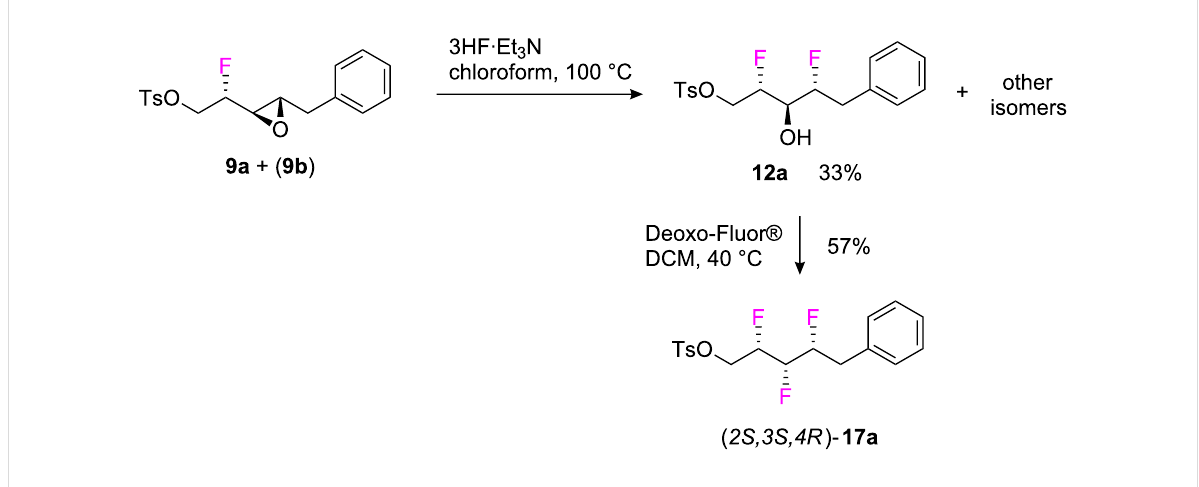
Scheme 8: Epoxide ring opening with 3HF·Et 3 N and synthesis of the all- syn vicinal trifluoro tosylate 17a